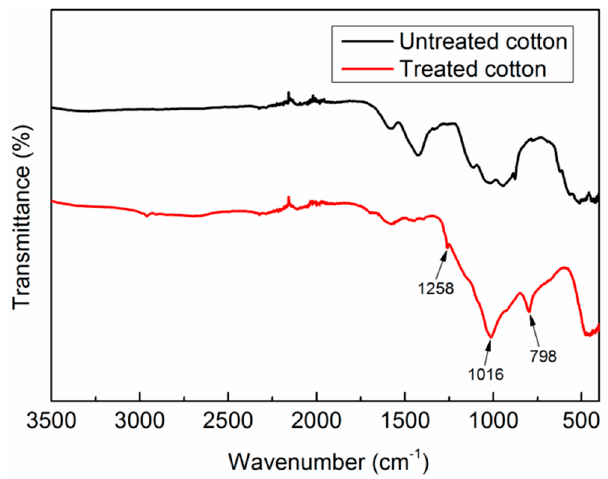
Figure 8. FTIR spectra for carbon residues of untreated and treated cotton fabrics.